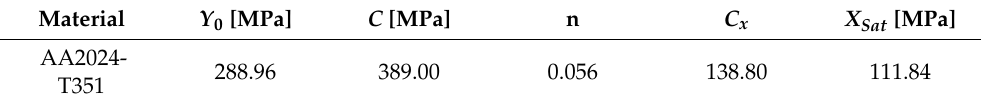
Table 1. List of material parameters involved in the Swift and Lemaître–Chaboche